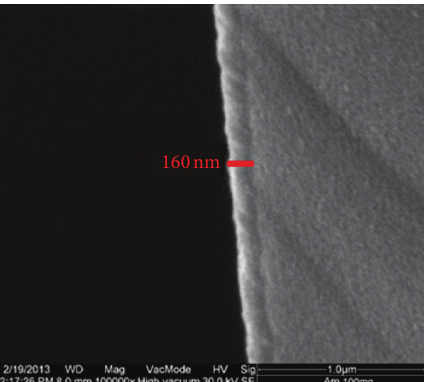
Figure 6: Scanning Electron Microscopy of the deposited film with 100 mg evaporated over the glass substrate.